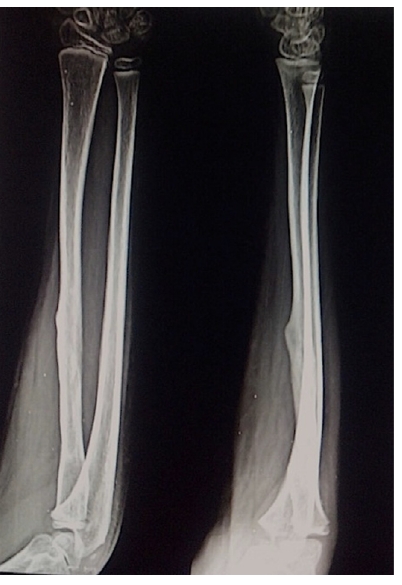
Figure 9. Two years follow-up roentgenograph showing fully incorporated graft into the host